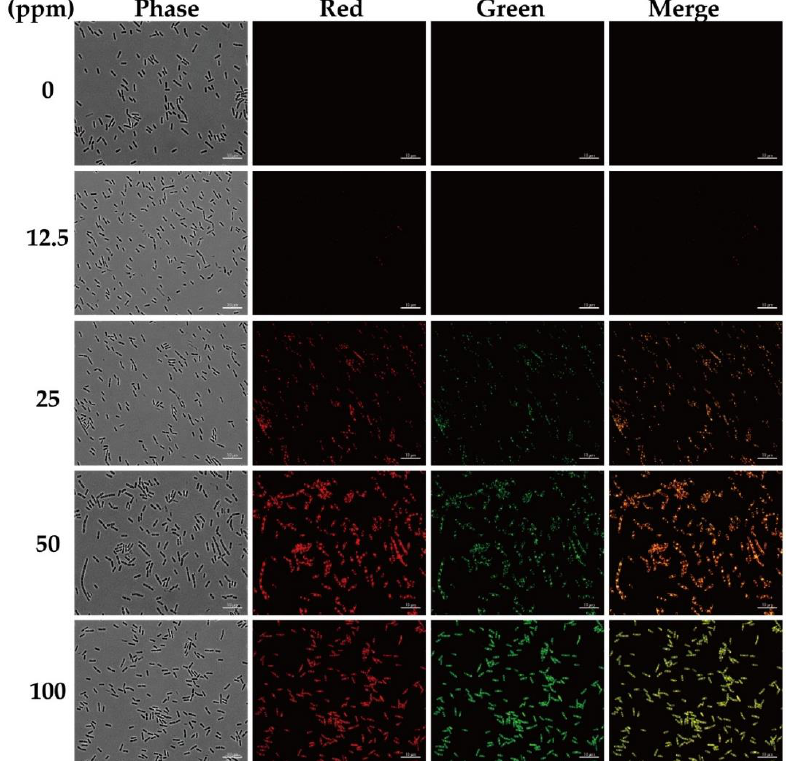
Figure 6. Fluorescence microscopy images of B. subtilis stained with PEG 6000 /CDs. Cells were stained with different concentrations of PEG 6000 /CDs (0, 12.5, 25, 50 and 100 ppm). Control cells were assayed similarly without adding PEG 6000 /CDs. TRITC filter detected red color, while FITC filter detected green color. Scale bar represents 10 μm.